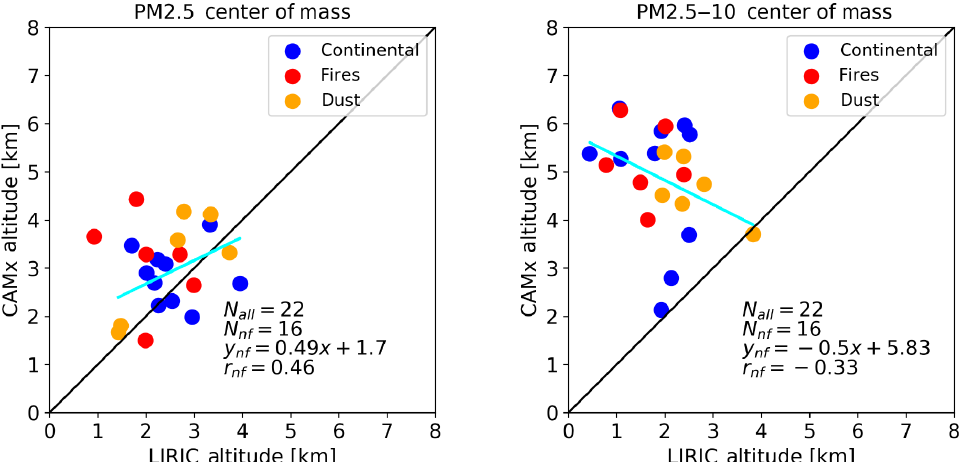
Figure 5. Scatterplots of the PM 2 . 5 (left) and PM 2 . 5 − 10 (right) center of mass for LIRIC and CAMx in the period 2013–2015. The biomass burning cases are marked with red, while the dust cases are marked with orange. The “nf” label corresponds to metrics of the category “no fires”. The least square fit line corresponding to the screened cases (blue and orange) is also included. Table 3. Center of mass metrics. The category “All” corresponds to the total of the cases (22 in total), while the category “No Fires” refers to the cases that are not classified as wildfires (16 out of 22). The mean, standard deviation, mean bias and root mean square error values are in km units. Pearson’s correlation coefficient ( r ) and the least square fit slope (a) and intercept (b) values are also calculated. Mode Category LIRIC mean CAMx mean Mean bias Frac. bias (%) RMSE r a PM 2 .